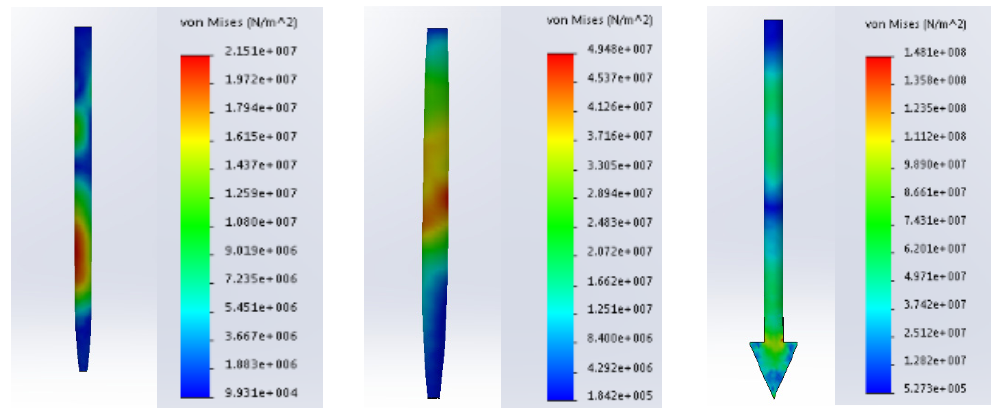
Figure 7. FEA of each of the different arrowheads showing the final simulation frame in each case: root ( left ), bone ( centre ) and iron ( right ).